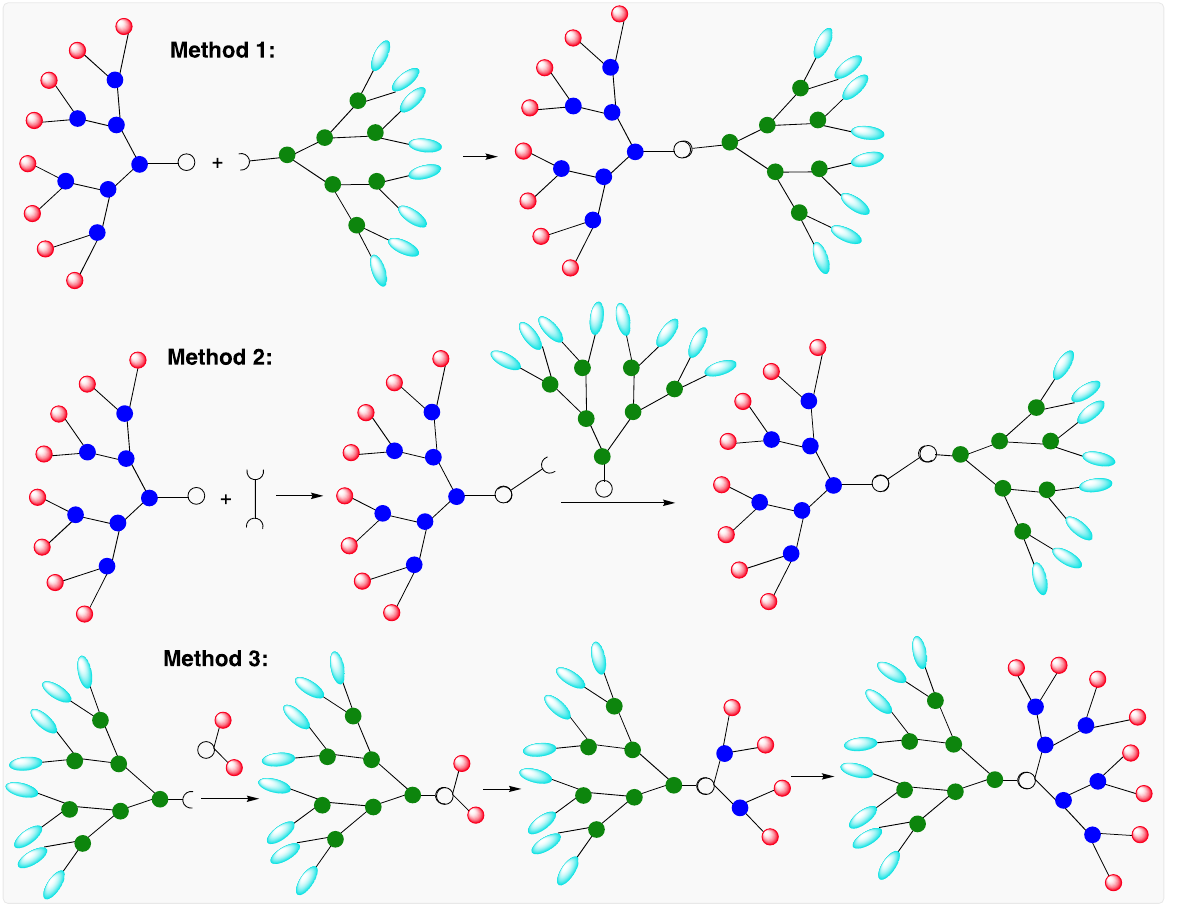
Scheme 1. General methods of synthesis of Janus